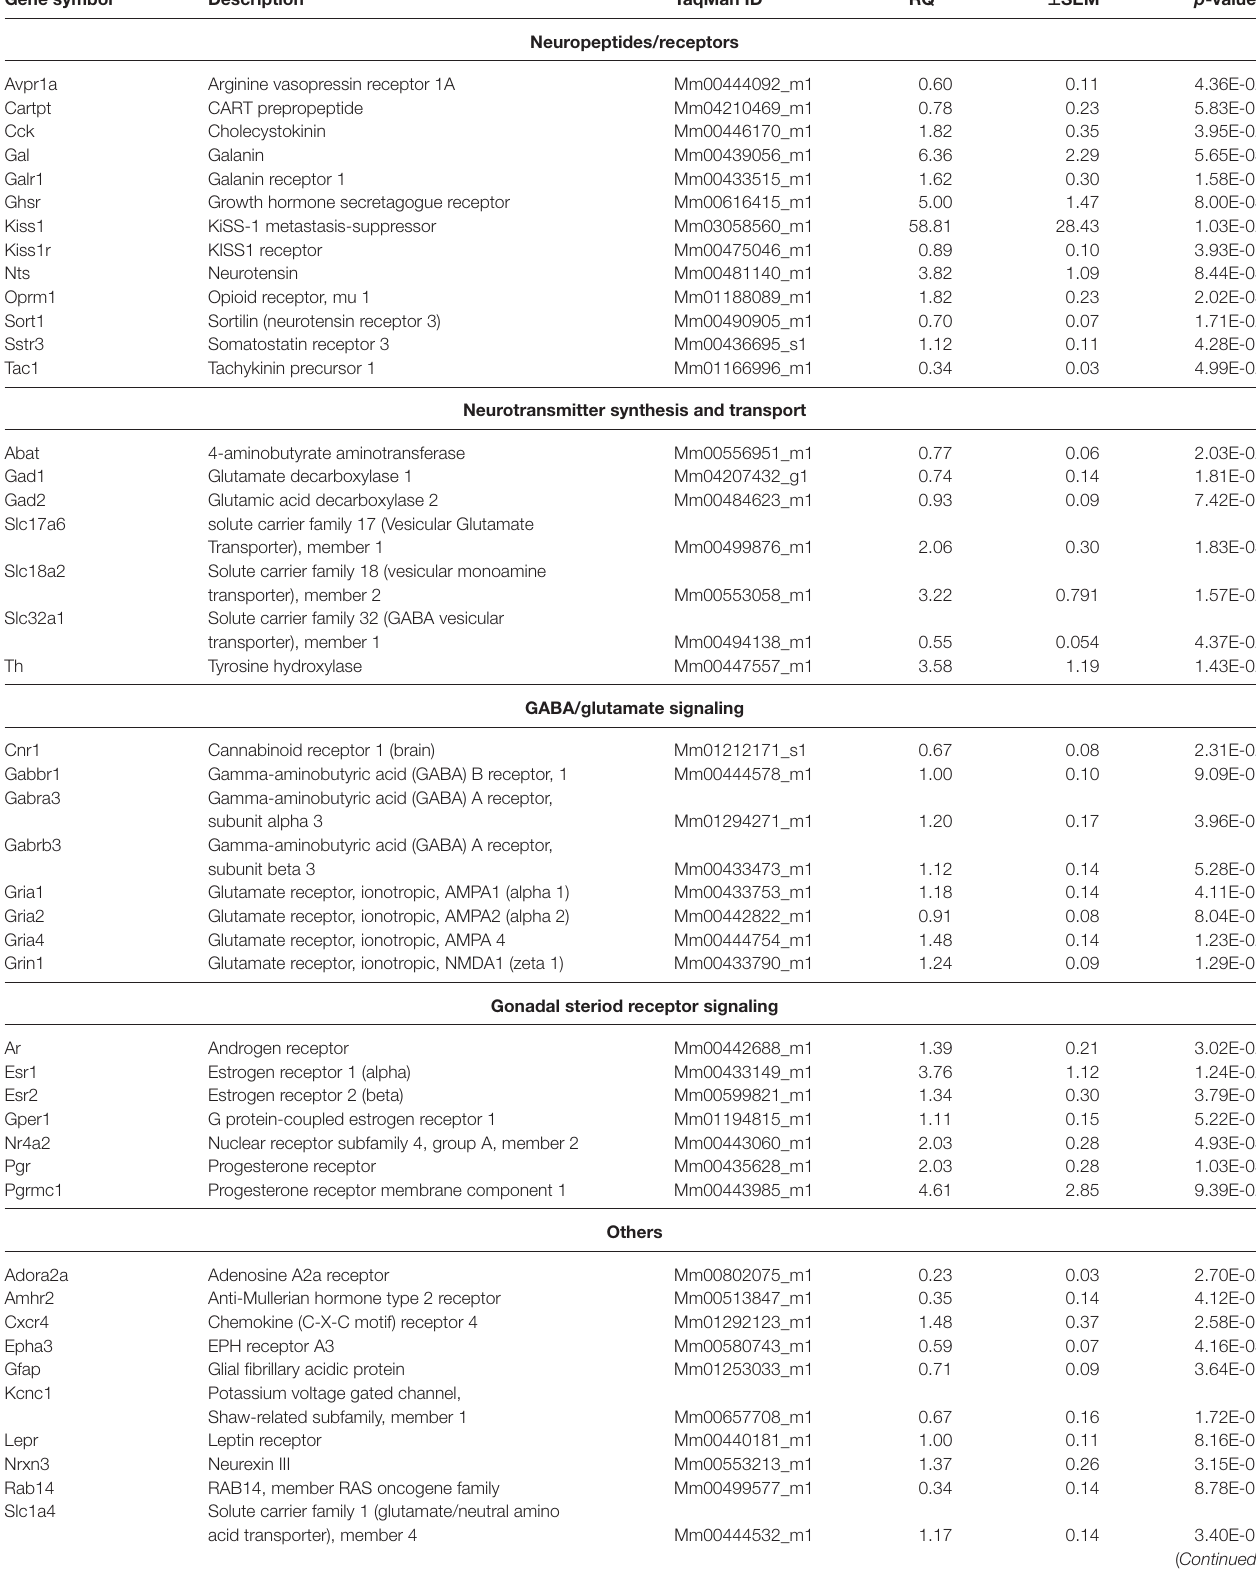
TABLE 1 | PCR analysis of genes regulated differentially in proestrus in the antero-ventral periventricular/medial preoptic area of the mouse. Gene